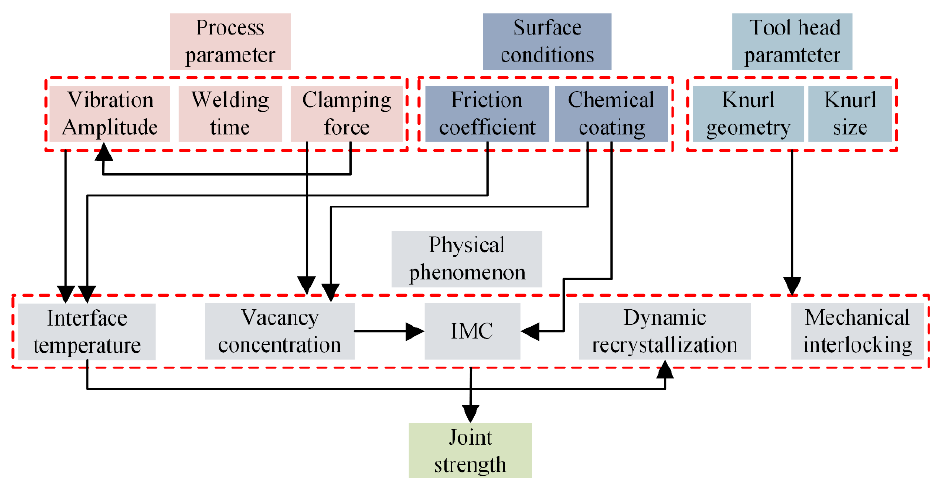
Figure 2. Influence mechanism of welding process parameters, material parameters and tool head parameters on the USW process.